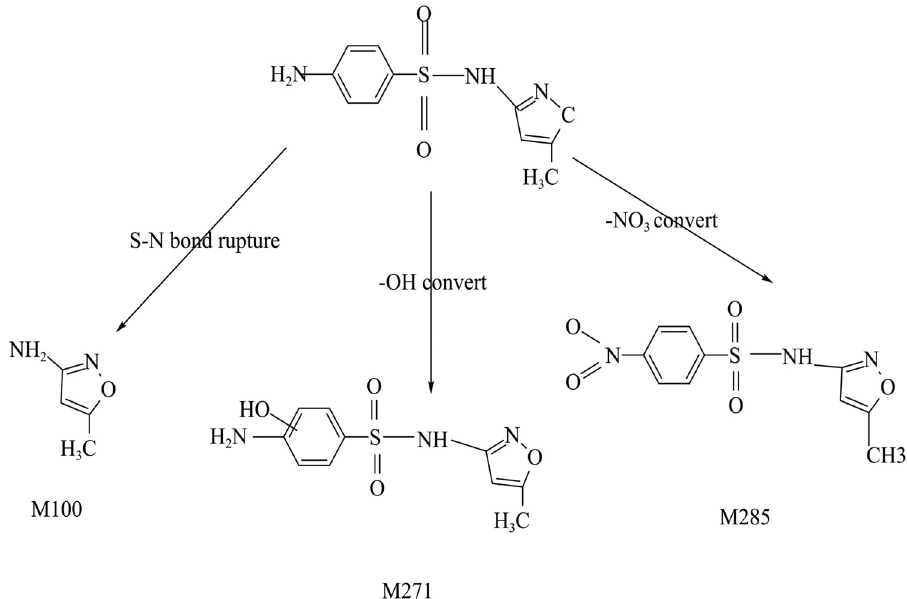
Figure 8: Degradation pathway of SN antibiotic SMZ in visible light.